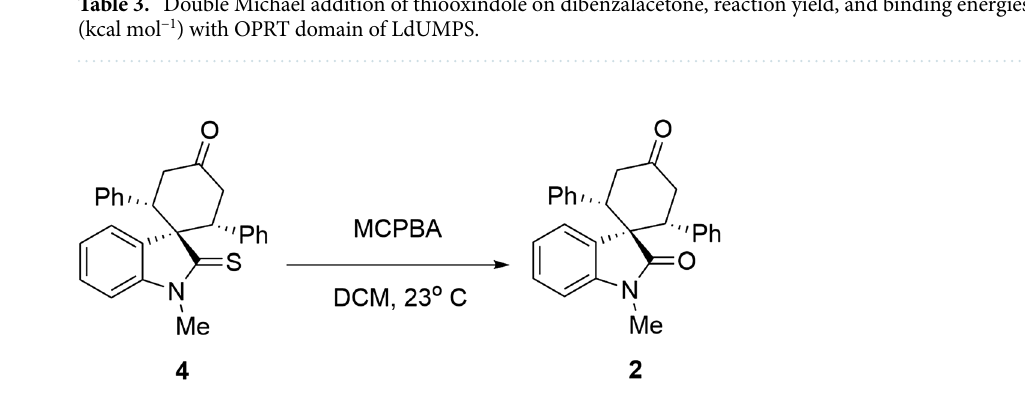
Figure 7. Conversion of cis -spirothiooxindole into cis